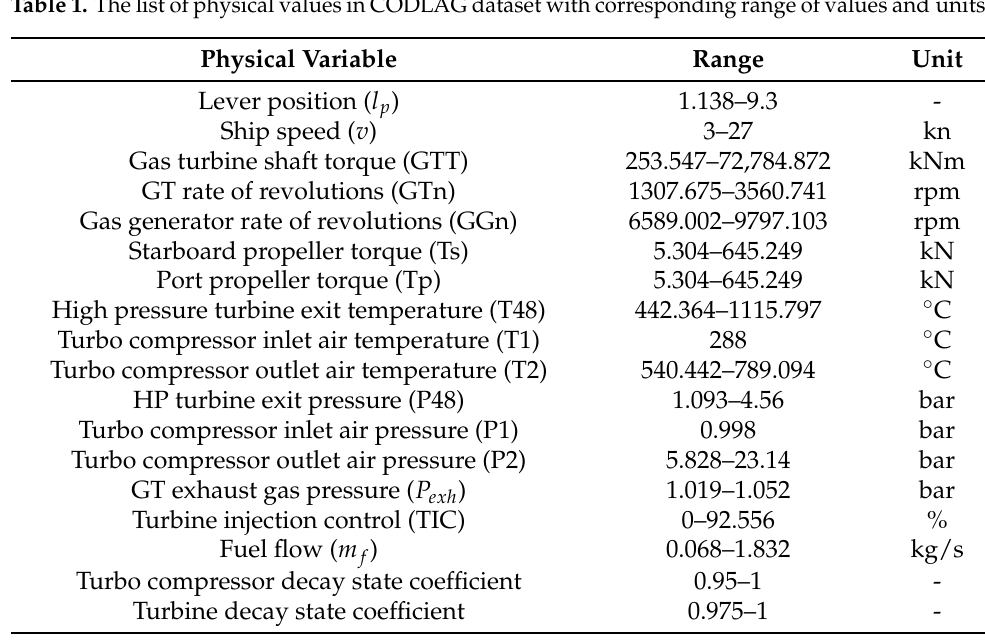
Figure 3. Thermodynamic process of the gas turbine from the analyzed CODLAG propulsion system in T-s diagram (O.P.-Operating Point). Table 1. The list of physical values in CODLAG dataset with corresponding range of values and